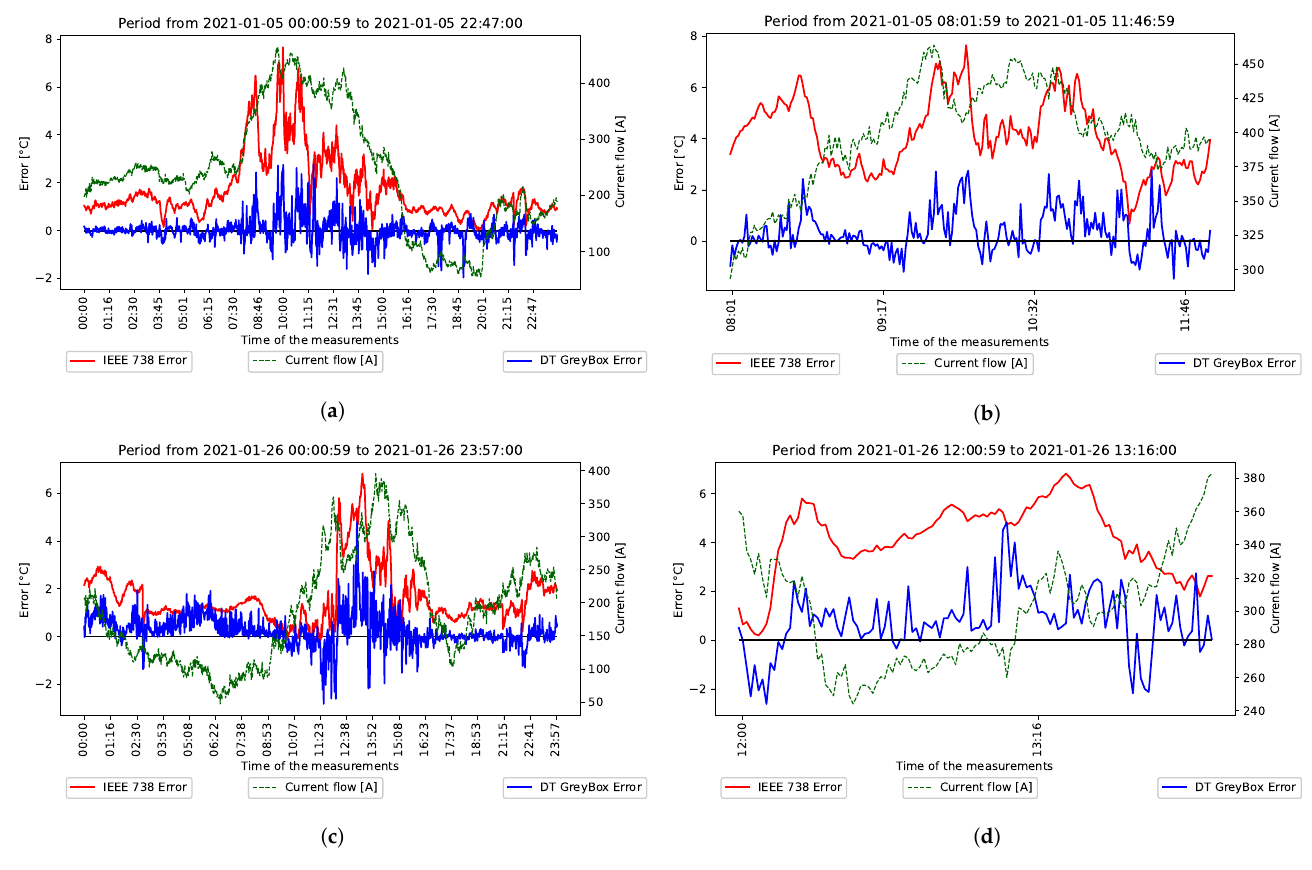
Figure 9. A visualization of the fourth and fifth critical areas for the IEEE 738 standard from Table 2. The error, defined by Equation (9), is represented for both the IEEE 738 standard and the grey-box proposed approach. Additionally, the most related feature, according to Table 2, is plotted. ( a , b ) report 2021-01-05, where ( b ) is a zoom on the area of interest of ( a ); ( c , d ) report 2021-01-26, where ( d ) is a zoom on the area of interest of ( c ). In all cases, a rapid variation of the measure is most correlated with the error in the moment of its peak.